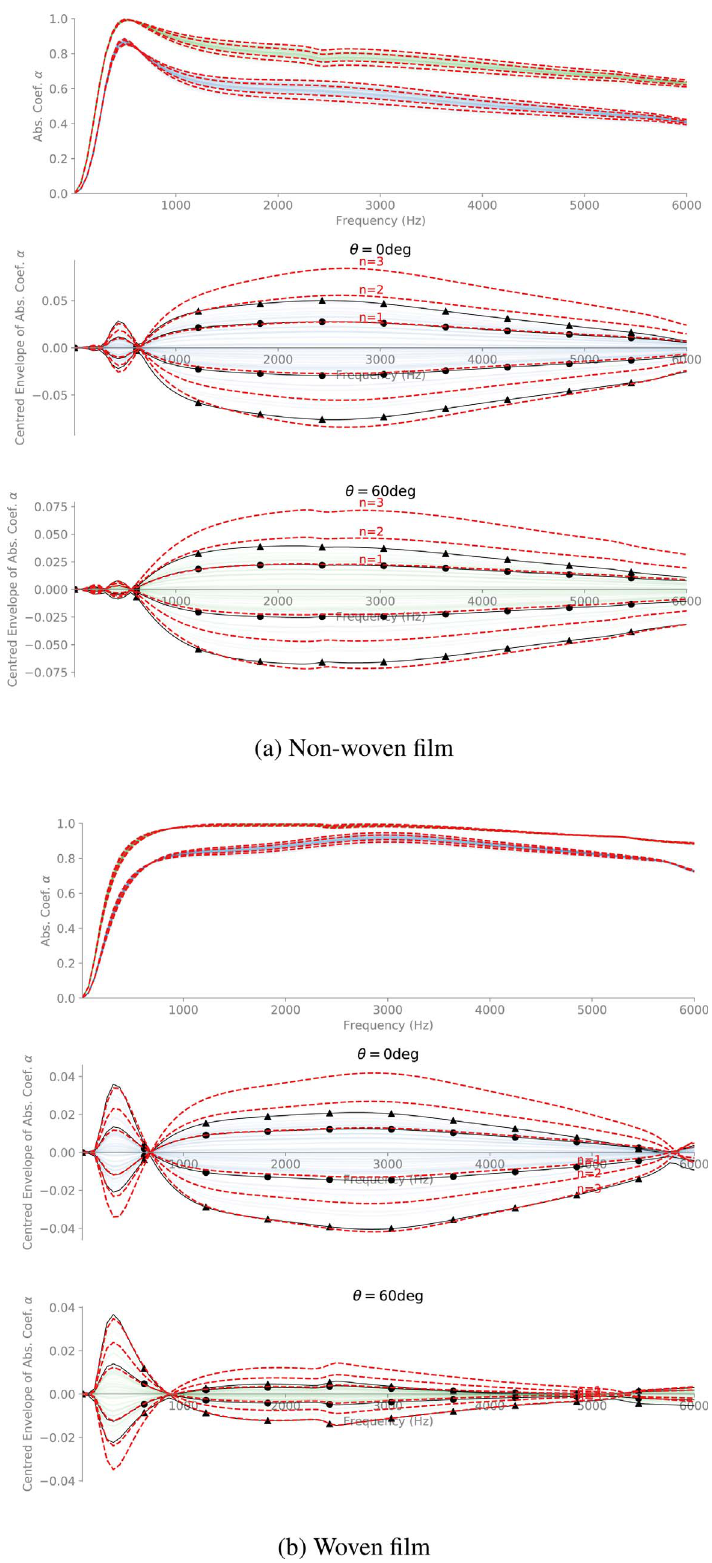
Figure 6. Case of a varying thin fi lm placed over two layers of poro-elastic media of thickness 10 mm and 30 mm. Quantities and line styles identical to Figure